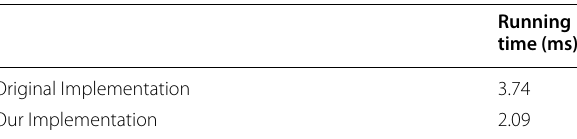
Table 8 Running time of the G-lattice sampling algorithm in PALISADE at 3.6